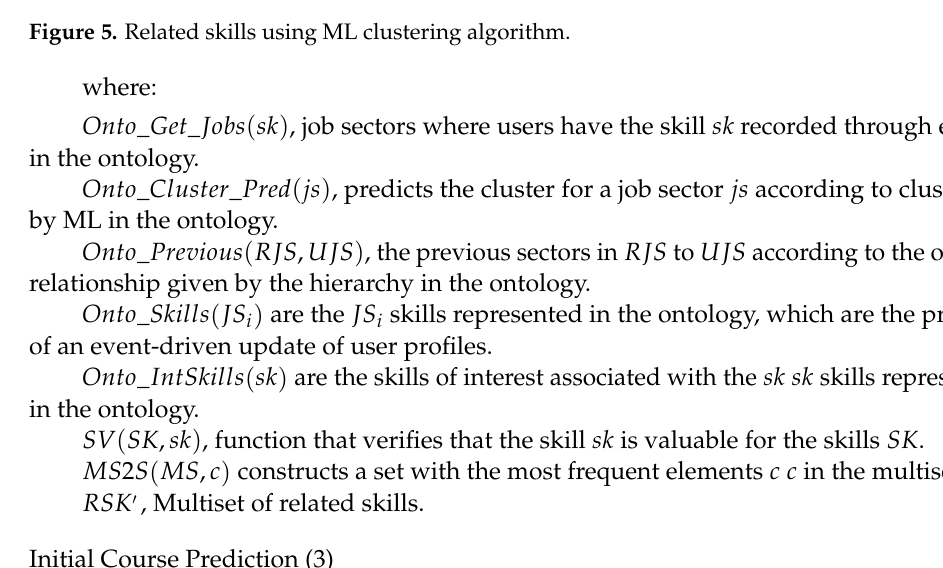
Figure 5. Related skills using ML clustering algorithm.